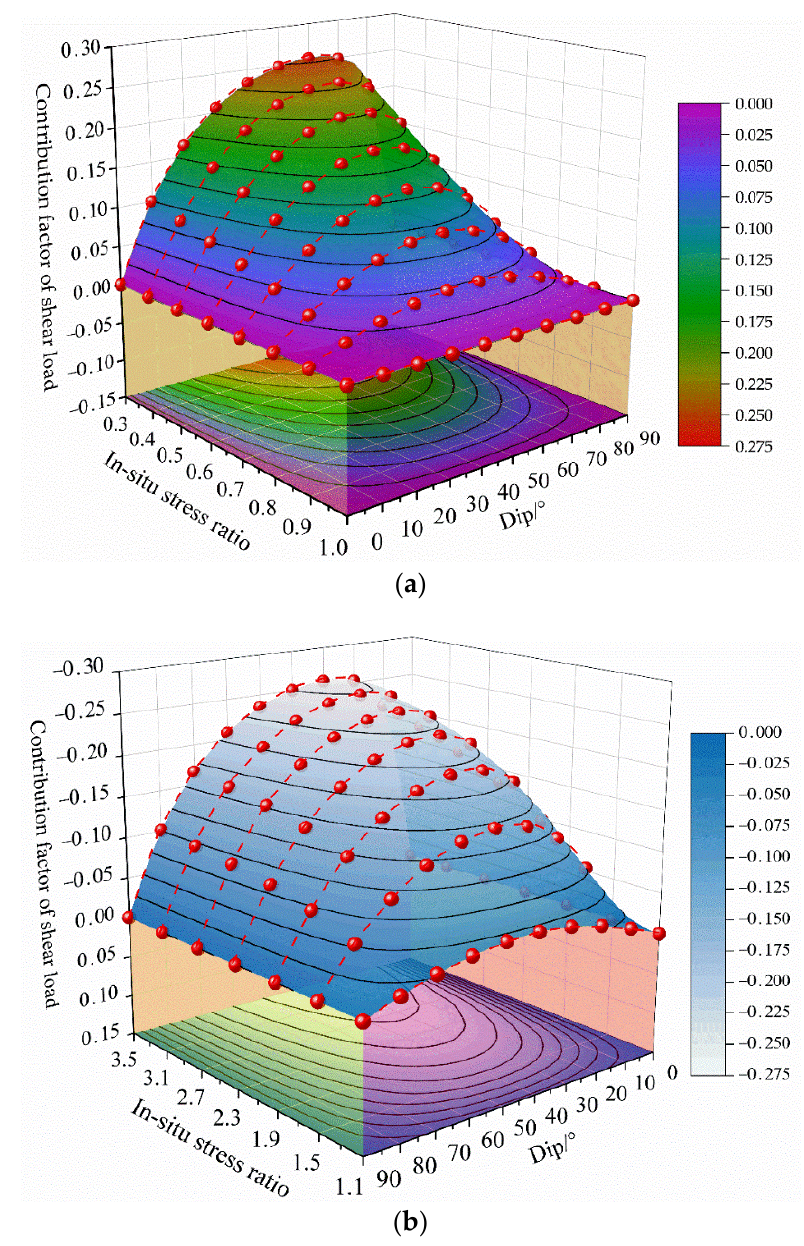
Figure 13. Relationship between the contribution factor of shear load ( CFSL ) and dip angle; ( a ) k ∈ [0.3, 1]; ( b ) k ∈ (1,